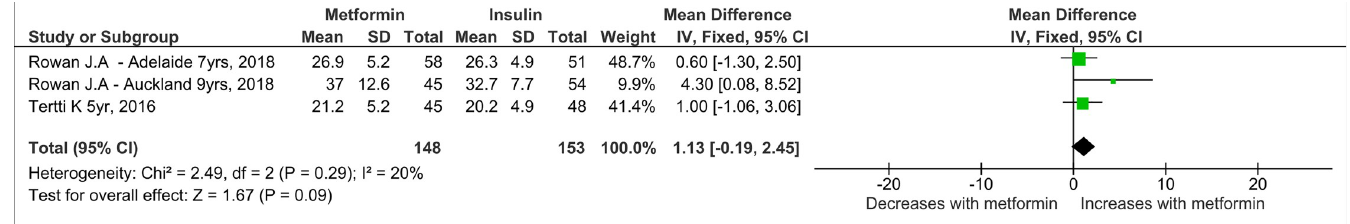
PLOS Medicine| https://doi.org/10.1371/journal.pmed.1002848 August 6,